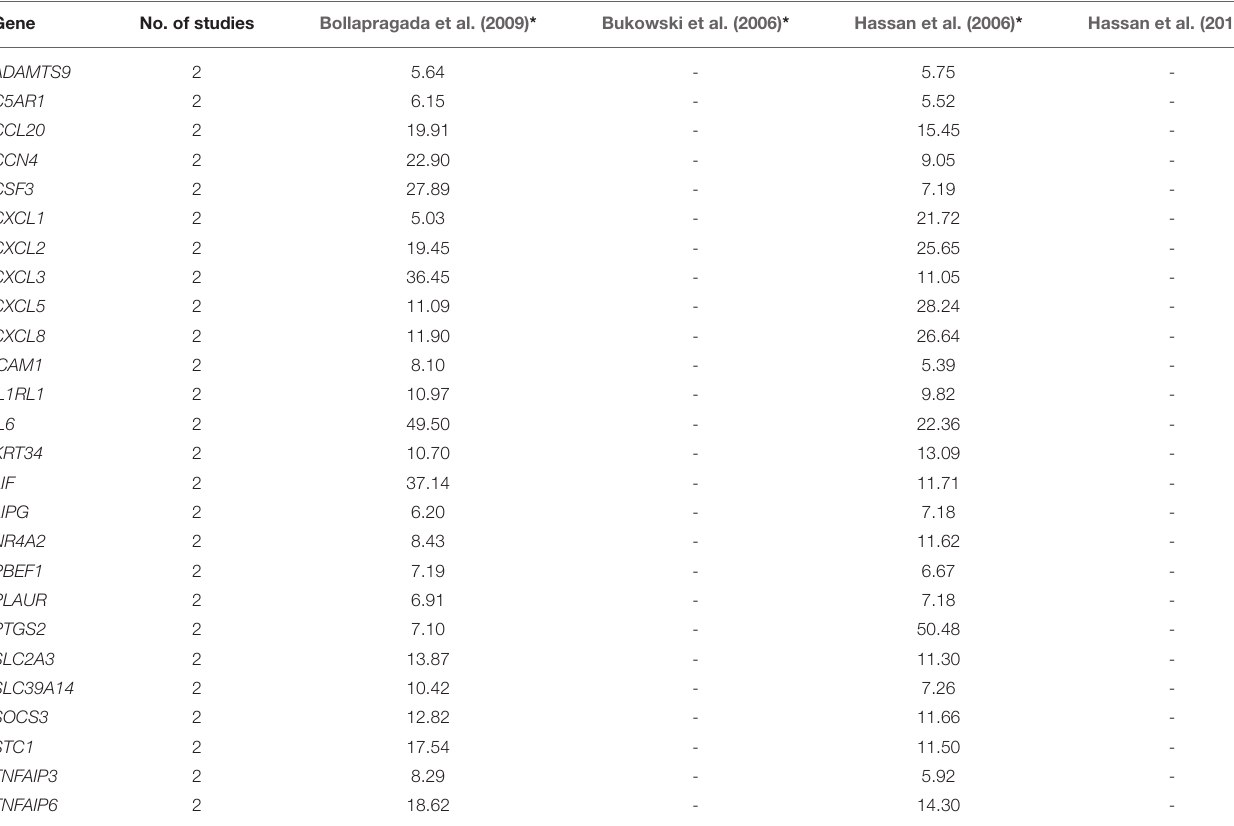
processes pathways ( Figure 2A , blue dots) were enriched in the same comparison.